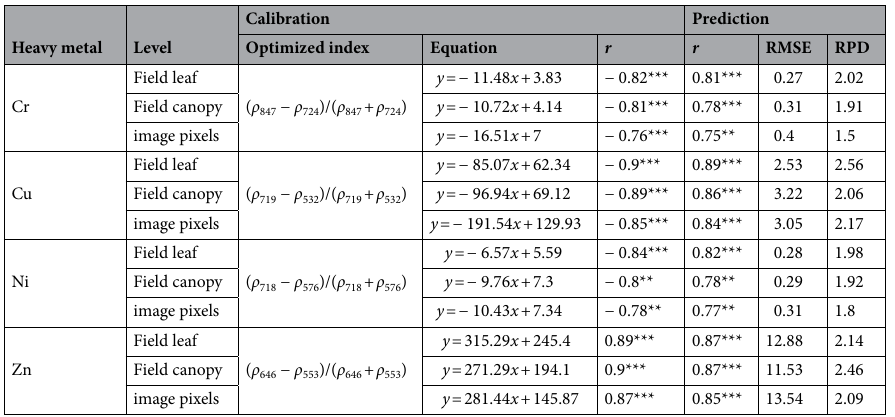
Table 2. Summary of the performance of the optimized vegetation indices developed for predicting leaf heavy metal contents. For each of the four metals, the results obtained at leaf, canopy and image levels are presented on the calibration and prediction sets. r Pearson’s coefficient of correlation, RMSE root mean square error, RPD residual predictive deviation. ** p < 0.01; *** p <